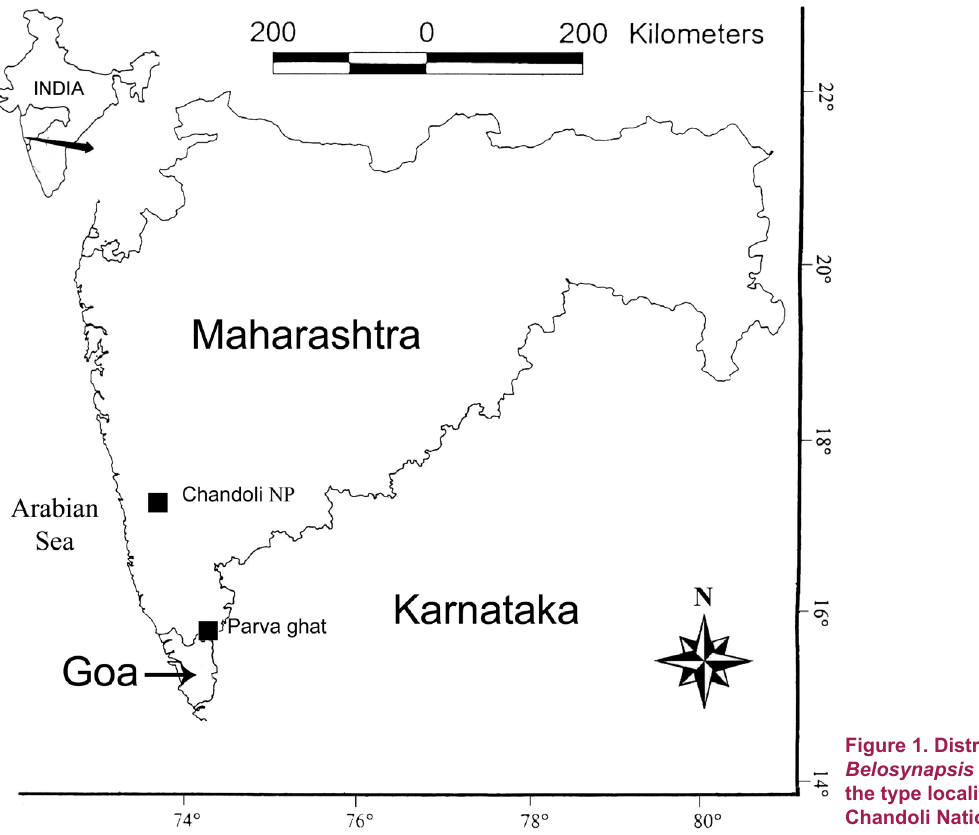
Figure 1. Distribution map of Belosynapsis vivipara showing the type locality (Parva Ghat) and Chandoli National